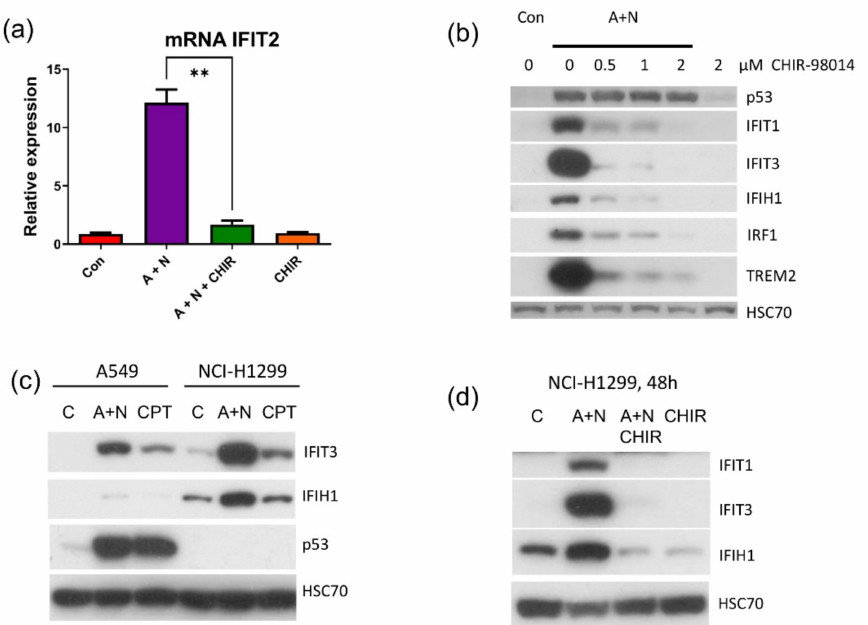
Figure 12. CHIR-98014 attenuates the expression of innate immunity genes stimulated by A + N without the assistance of p53. ( a ) Relative expression of IFIT2 mRNA in cells exposed as demonstrated for 30 h (CHIR, 1 µ M). Statistical differences in expression were calculated using unpaired t test with Welch’s correction (** p < 0.01). ( b ) The expression of indicated proteins in A549 cells exposed to A + N or A + N with various concentrations of CHIR-98014 for 48 h. ( c ) The expression of p53, IFIT3 and IFIH1 proteins in cells with wild-type p53 or expressing no p53. The cells were exposed to A + N or camptothecin (CPT) for 48 h. ( d ) The expression of the innate immunity proteins in p53-null NCI-H1299 cell line exposed as indicated (CHIR, 2 µ